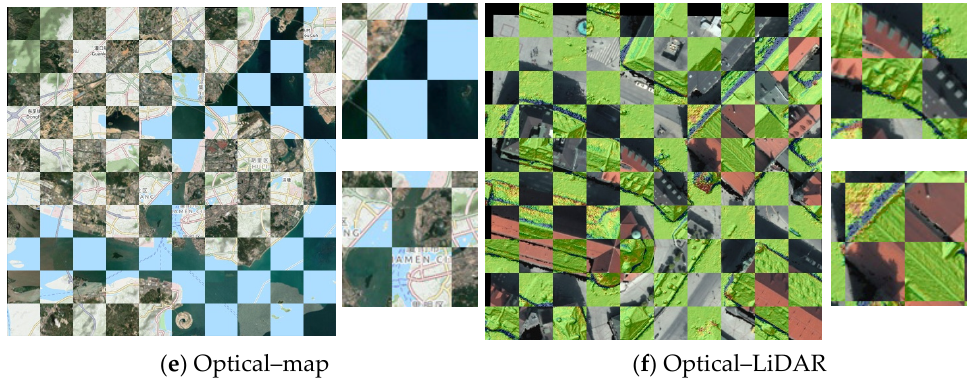
Figure 22. Image registration results and enlarged images.